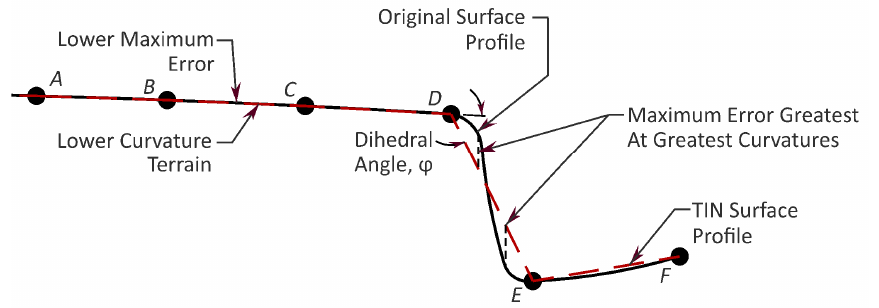
Figure 2. Simulated terrain profile, including a floodplain and a stream. Unlabeled black circles represent nearby Lidar sample points projected onto the 2D profile.